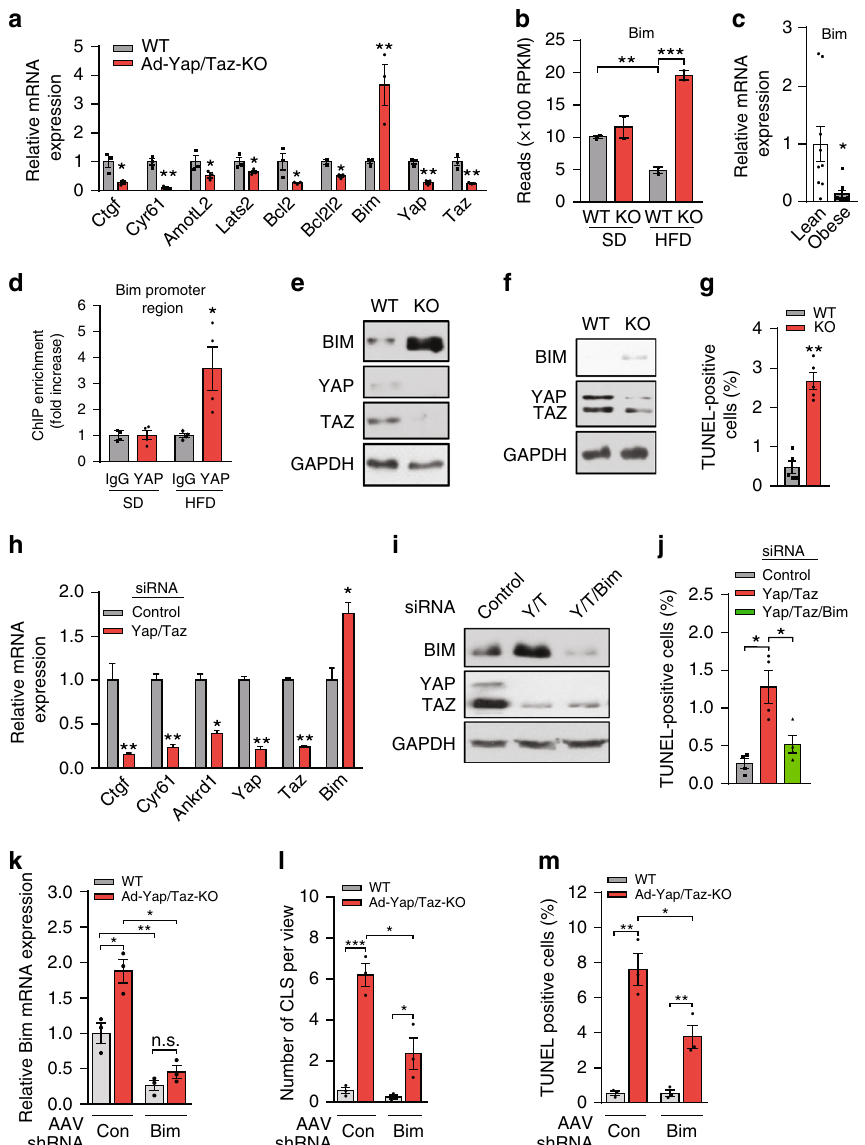
Fig. 4 YAP/TAZ promote adipocyte survival by suppression of Bim expression. a Quantitative RT-PCR showing mRNA expression of Yap, Taz, and their target genes including pro- and anti-apoptotic factors in white adipocytes isolated from WT and Ad-Yap/Taz-KO mice fed HFD for 4 weeks ( n = 3 mice per group). b RNA-seq data showing expression of Bim (Bcl2l11) in white adipocytes isolated from WT and Ad-Yap/Taz-KO mice fed HFD or standard diet for 4 weeks ( n = 2 mice per group). c Expression of Bim in isolated adipocytes from the vWAT of lean (BMI < 25) and obese humans (BMI > 30) ( n = 9 in both groups). d Chromatin immunoprecipitation (ChIP) PCR of the TEAD-binding site in the Bim promoter region in lysates of vWAT prepared from WT mice fed standard diet (SD) or HFD for 4 weeks using an anti-YAP antibody (#4912, Cell Signaling Technology) ( n = 4 mice per group). e , f Western blot analysis showing BIM protein level in white adipocyte isolated from WT and Ad-Yap/Taz-KO mice (KO) fed HFD for 4 weeks ( e ) and in adipocytes differentiated from the SVF of WT and Ad-Yap/Taz-KO mice (KO) ( f ). g Apoptotic cell death detected by TUNEL staining of adipocytes differentiated from SVF of WT and Ad-Yap/Taz-KO mice ( n = 5 mice per group). h Quantitative RT-PCR showing mRNA expression of YAP/TAZ target genes in differentiated 3T3-L1 adipocytes treated with control siRNA or siRNA directed against Yap and Taz ( n = 3). i , j Differentiated 3T3-L1 adipocytes were treated with control siRNA or siRNA directed against Yap, Taz, and Bim, and western blot analysis was performed to analyze protein levels of BIM, YAP, TAZ, and GAPDH ( i ). In parallel, cells were analyzed by TUNEL staining to determine cell apoptosis ( j ) ( n = 4). k Bim expression in adipocytes isolated from vWAT 4 weeks after injection of adeno-associated virus transducing control shRNA (AAV-Con) or shRNA directed against Bim (AAV-shBim) fed HFD ( n = 3 mice per group). l , m Quanti fi cation of crown-like structures (CLS) ( l ) and of TUNEL-positive cells ( m ) in sections of vWAT from WT and Ad- Yap/Taz-KO mice 4 weeks after injection of adeno-associated virus transducing control shRNA (AAV-Con) or shRNA directed against Bim (AAV-shBim) and fed HFD ( n = 3 mice per group, at least 10 sections were analyzed per animal). Data are presented as the mean ± SEM; *p ≤ 0.05 and **p ≤ 0.01 (unpaired Student ’ s t -test in a , c , g , h and one-way ANOVA in b , d , j – m ). Source data are provided as a Source Data fi